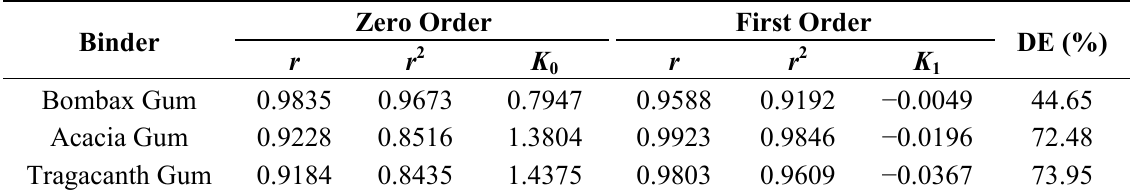
Table 3. Outcomes of mathematical modeling of drug release